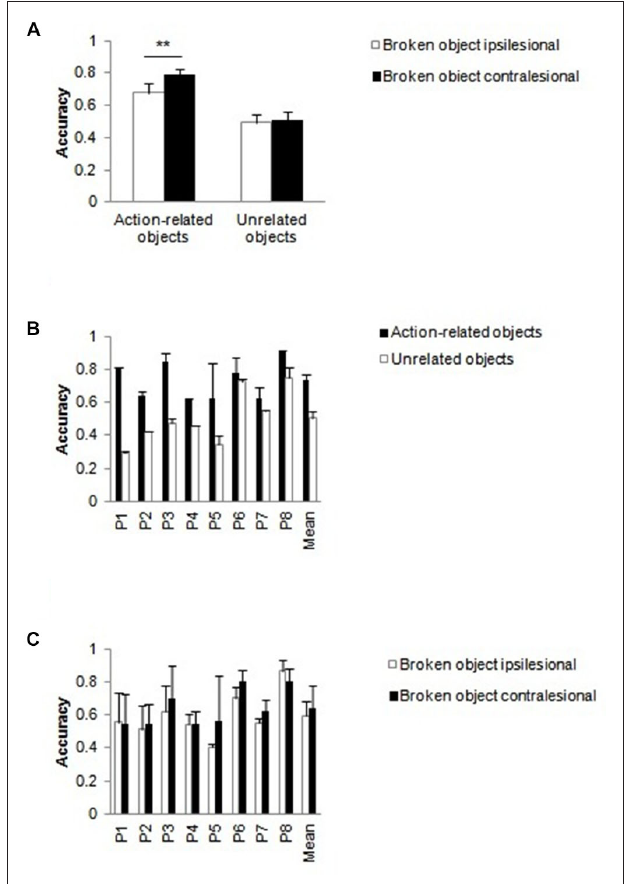
FIGURE 7 | Action-related objects vs. unrelated objects, with a broken object handle. (A) Mean accuracy of performance for action-related and unrelated object pairs as function of whether the broken object handle was on the contralesional or on the ipsilesional side. (B) Mean patient accuracies as function of condition (B) and side of broken object (C) with error bars indicating SE. Asterisks denote significance ( ∗∗ p < 0.01).